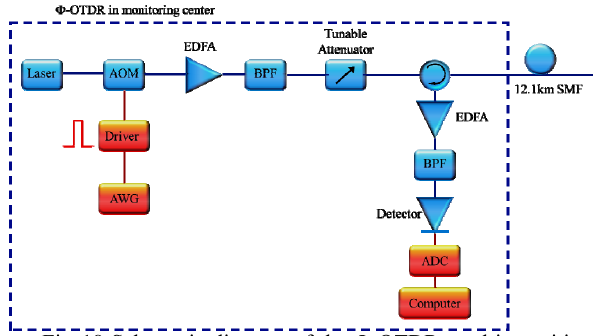
Fig. 18 Schematic diagram of the Φ -OTDR used in position and speed monitoring of